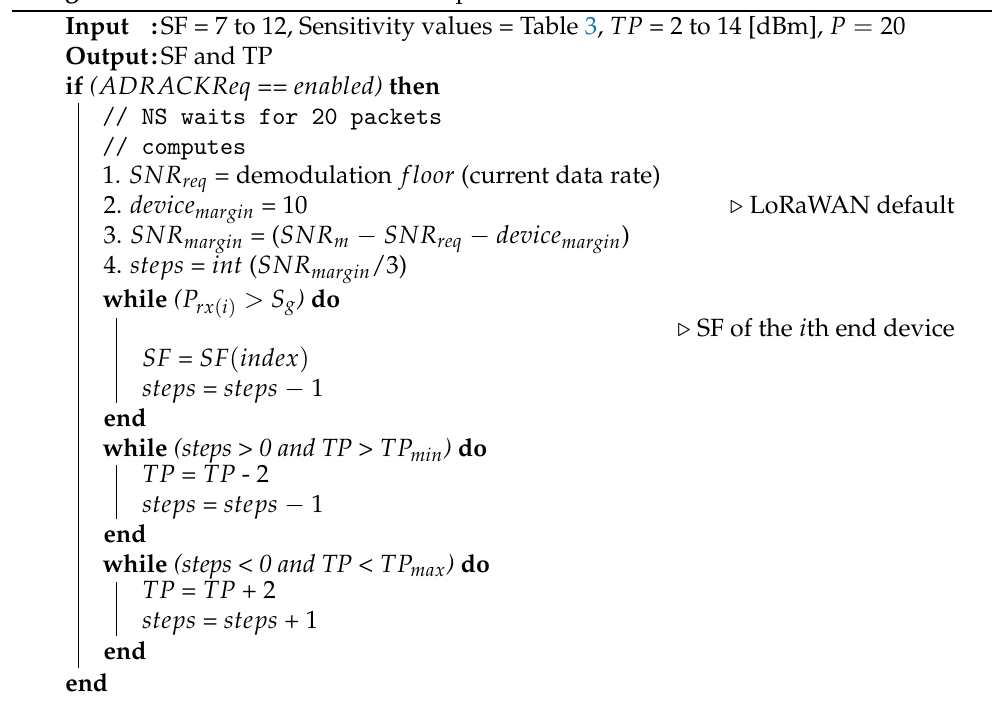
Algorithm 2: The Network Server Proposed ADR